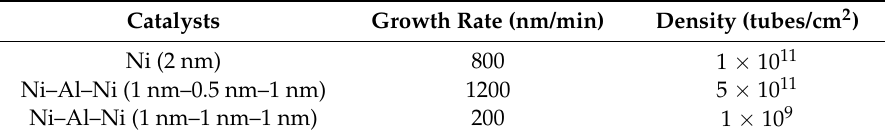
Table 1. The growth rate and density of CNTs grown at 450 °C with different catalysts.